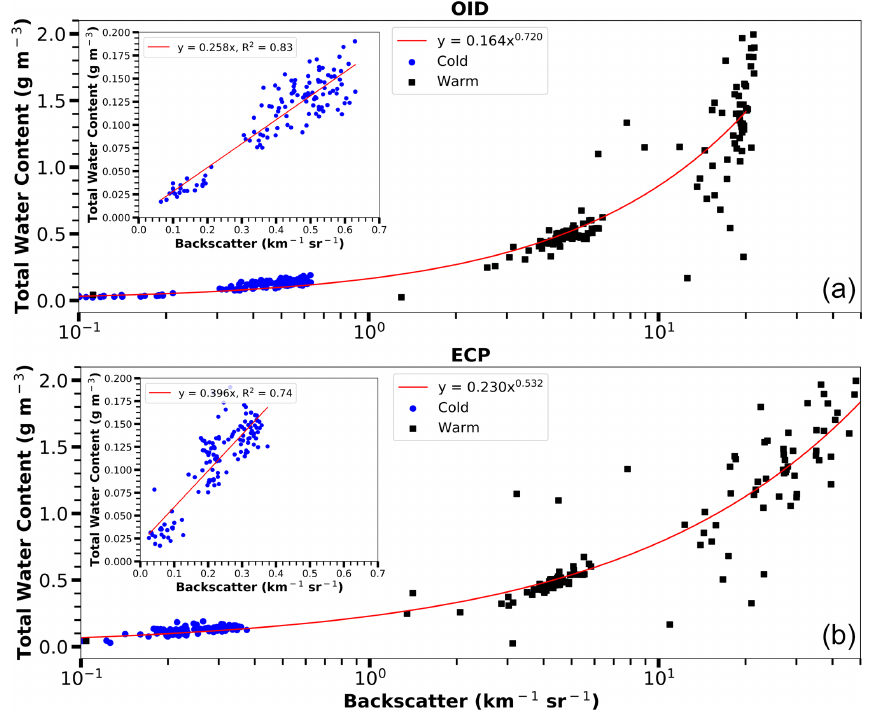
Figure 9. Plots showing Nevzorov probe total water content (TWC) versus Optical Ice Detector (OID) backscatter coefficients (a) and external cloud probes (ECP) backscatter coefficients (b) with a logarithmic x axis. Backscatter coefficients are separated by warm ( + 7 and + 4 ◦ C) cases (square, black) and cold ( − 33 and − 46 ◦ C) cases (round, blue) (Table 2). Insets in the top-left corners show further detail of the Nevzorov probe TWC versus respective backscatter coefficients for the − 33 and − 46 ◦ C cases. Each point represents 1s of Nevzorov, OID, and ECP data. The ECP backscatter coefficient is obtained using image data processed with the area-equivalent method for all